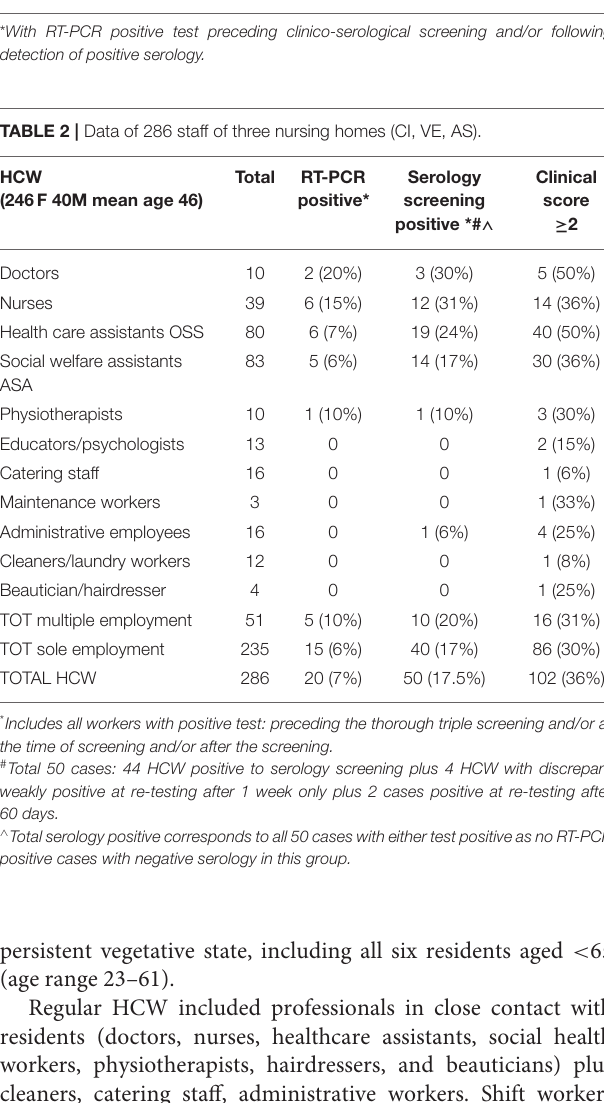
TABLE 2 | Data of 286 staff of three nursing homes (CI, VE, AS).